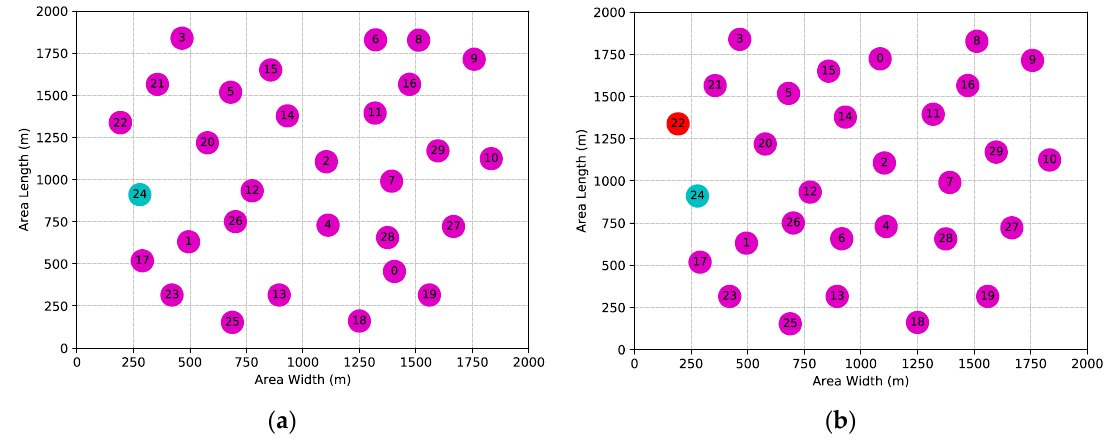
Figure 5. Network topology consisting of 30 SUs: ( a ) Route establishment by self-learning, and ( b ) route establishment by apprenticeship learning. Table 1. Simulation parameters.